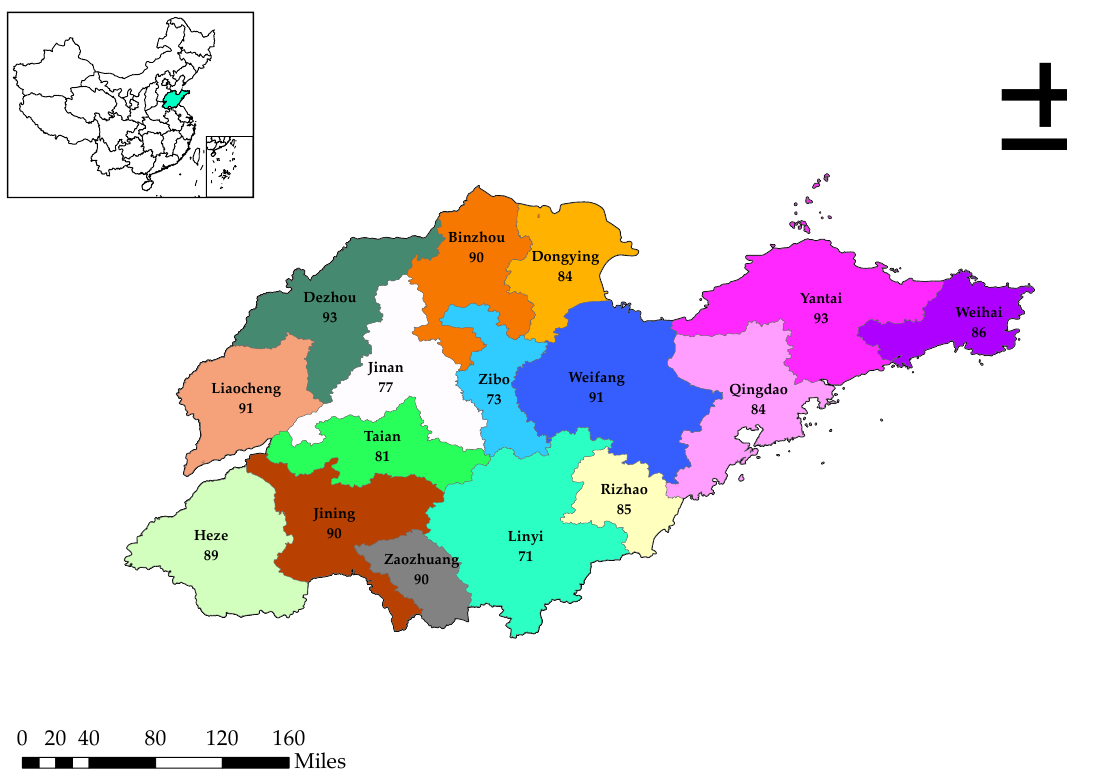
Figure 1. Geographical Distribution of Samples.